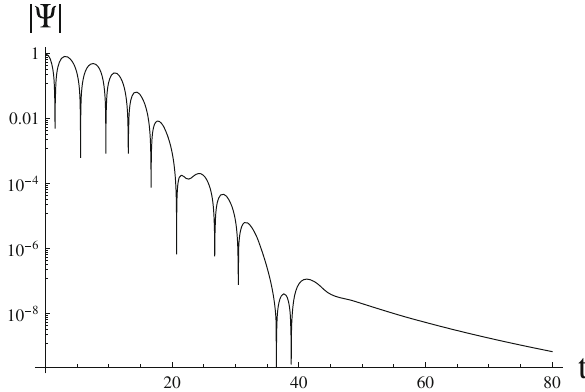
Fig. 7 Time-domain profile for the vector (axial) type of gravitational perturbations (cid:11) = 2 for α = − 1 . 9. The two dominating modes are ω = 0 . 676472 − 0 . 506277 i and ω 0